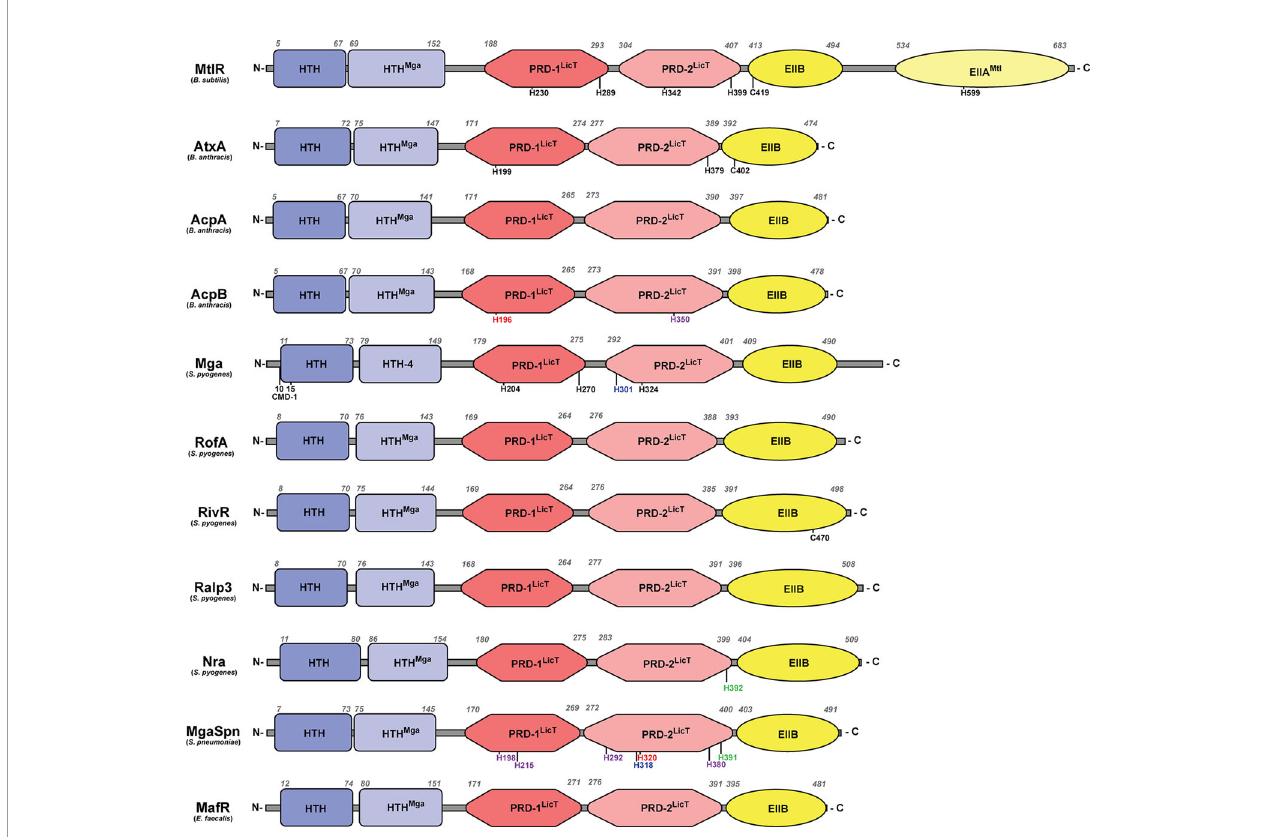
FIGURE 2 | Structural domains of PCVRs. Structural domains of each PCVR, with MtlR included for comparison, include two putative DNA-binding domains at the N-terminus, two central PRDs, and one EIIB-like domain that is structurally similar to the EIIBs speci fi c for galactitol, mannose, and lactose. Italicized numbers above each peptide indicate amino acid residues as landmarks starting from the N-terminus. Black residues are sites of phosphorylation, with the exception of C402 and C470 which are implicated in dimerization in AtxA and RivR, respectively. Green residues align with AtxA residues that undergo phosphorylation. Red residues align with Mga residues that undergo phosphorylation. Blue residues align with MtlR residues that undergo phosphorylation. Purple residues align with AtxA and/or Mga but have no known ability to undergo phosphorylation. Conserved Mga domain